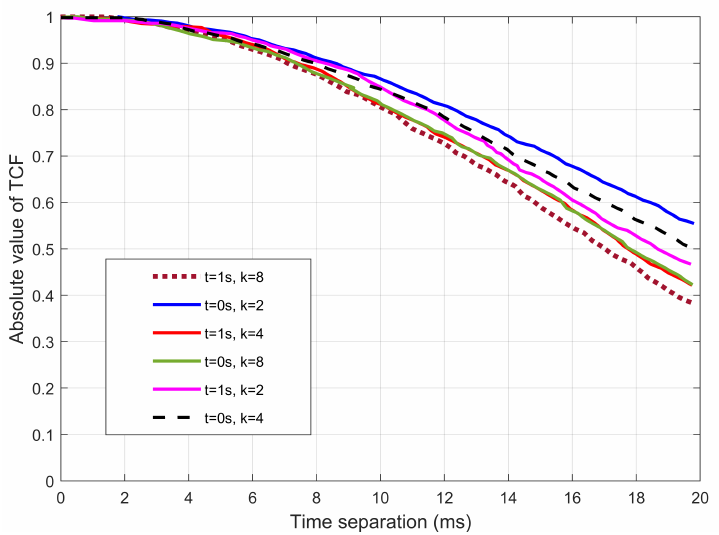
Figure 5. The relationship between the k distributions of intra-cluster paths and time correlations for elevation angles.